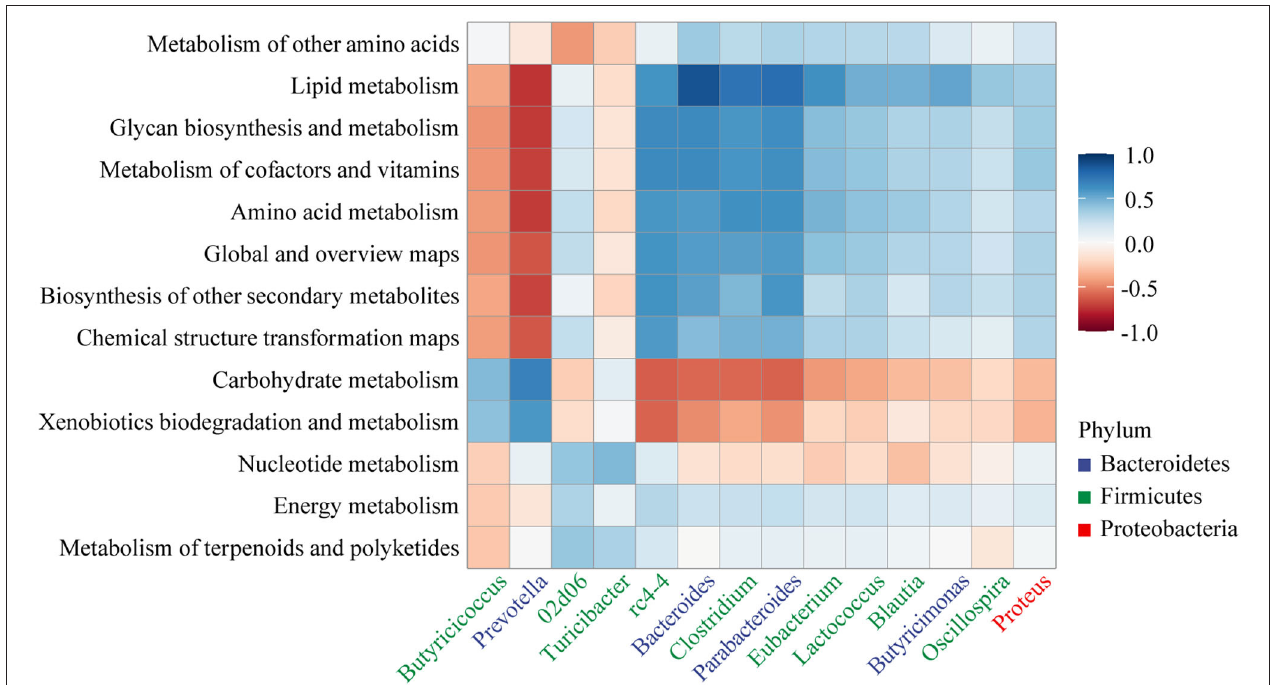
FIGURE 8 | Heatmap of the Pearson’s rank correlation coefficient between the KEGG pathway (level 2) and gut